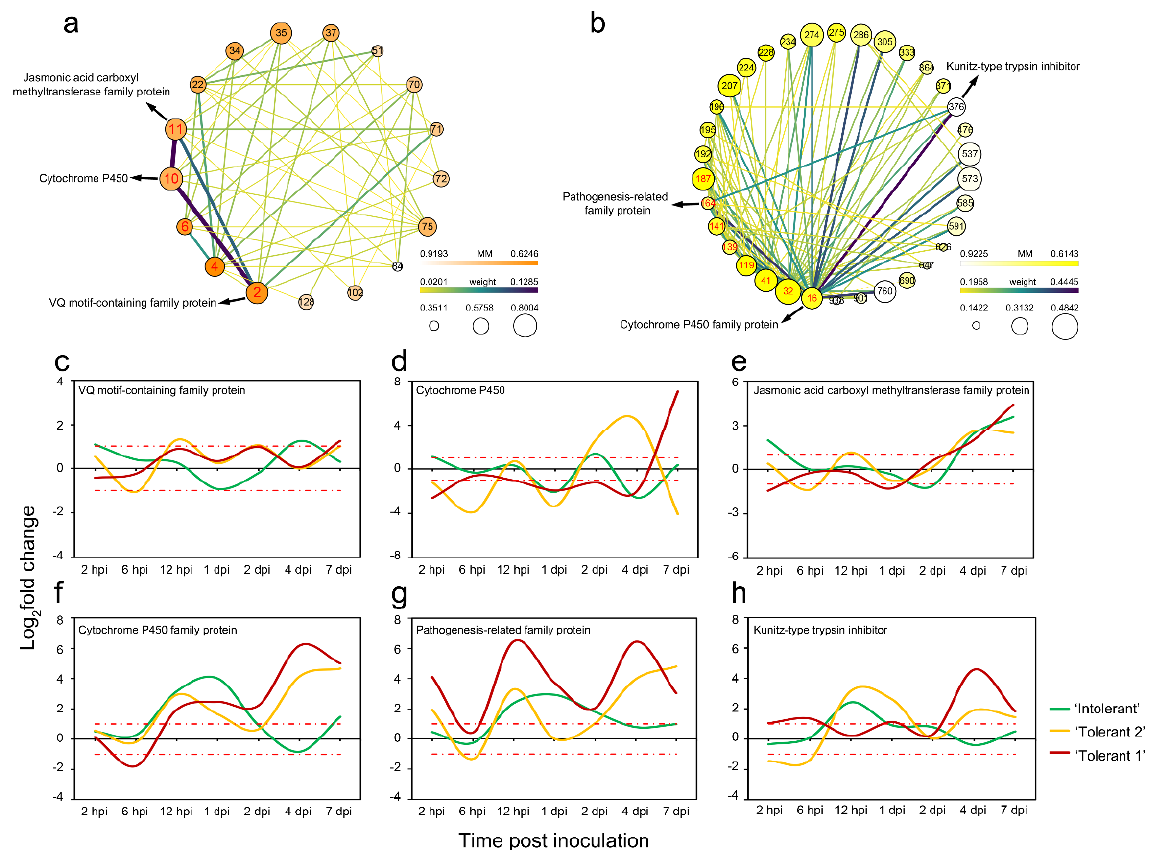
Figure 6. Gene networks for differentially expressed plant–pathogen interaction-related and signalling-related genes and highly related expression characteristics. ( a ) Gene network for differentially expressed plant–pathogen interaction-related and signalling-related genes in the JA-related module. ( b ) Gene network for differentially expressed plant–pathogen interaction-related and signalling-related genes in the free SA-related module (only genes with the top 100 highest weight values are shown). The size of the dots represents GS. The colour of the dots represents MM. The colours and thicknesses of the lines represent the weight value between two genes. The labels of dots are listed based on IC, and the hub genes are highlighted with red labels. ( c – h ) Comparison of the expression changes of highly related genes among the three poplars. GS, gene significance; MM, module membership; IC, intramodular connectivity.